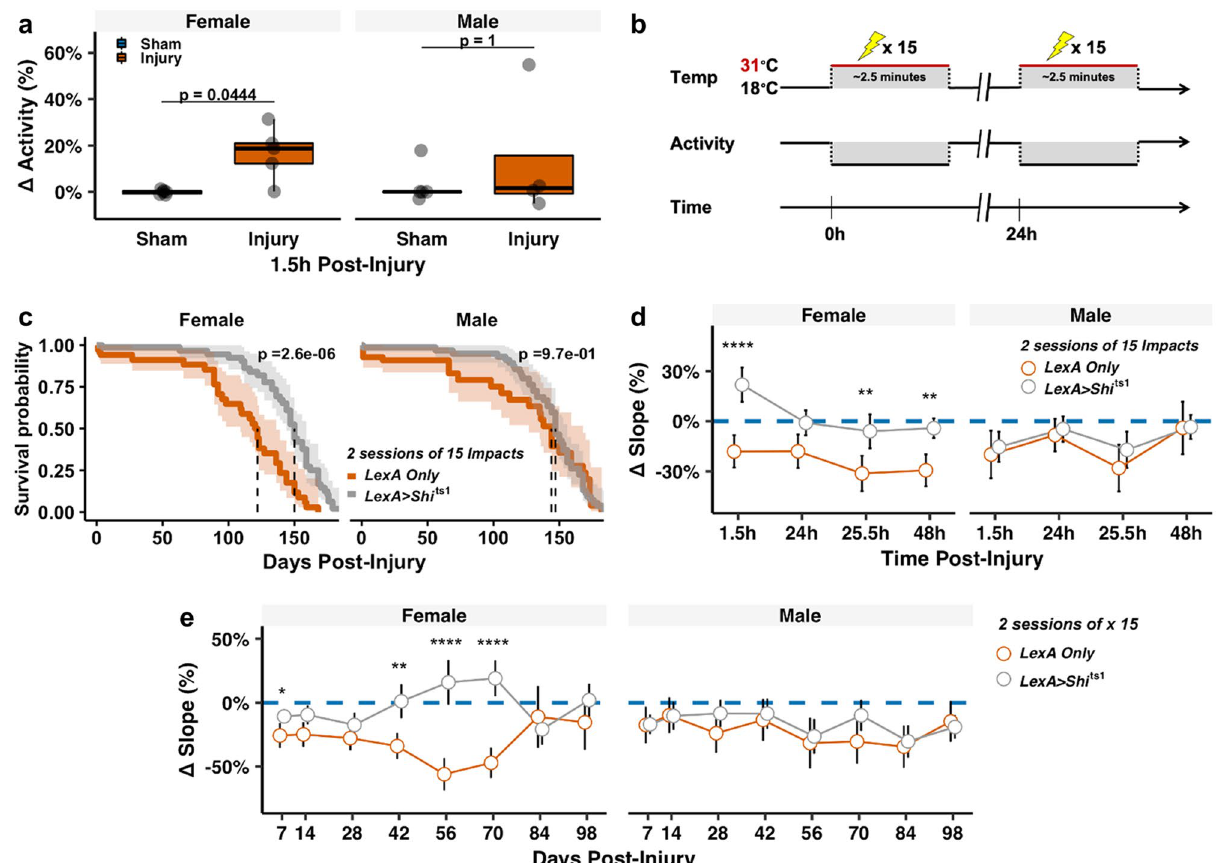
Figure 5. Long-term benefit of suppressing acute injury-induced neuronal activity following repetitive head impacts preferentially affects females. ( a) Quantification of neuronal activity using mushroom body in vivo calcium monitoring ( OK107 > CaLexA-LUC ) revealed an acute increase in neuronal activity 1.5 h following repetitive head impact exposure in lysates collected from injured female brains, but not males. Within sex differences between injury and sham were analyzed using the Mann–Whitney U test with Bonferroni correction, n = 4–7 lysates per group (2–4 fly heads per lysate). ∆ activity = ( (Sample luminescence)- (Median Sham Luminescence))/(Median Sham Luminescence). Boxplots contain individually plotted values with whiskers corresponding to the maximum 1.5 interquartile range. ( b) Schematic overview of strategy to conditionally silence neuronal activity using the pan-neuronally expressed temperature-sensitive hypomorphic null allele, Shibire ts1 during the repetitive injury induction period. 18 °C → 31 °C shift conditionally suppresses neuronal activity for 2.5 min during delivery of repetitive head impacts in pan-neuronally shi ts1 -expressing flies ( LexA > shi ts1 ). (c) Kaplan–Meier survival curves showing that blocking neuronal activity at the time of injury protects against shortened lifespan following injury exposure which preferentially benefits female flies. p -values were calculated using the Mantel-Cox log rank test with Bonferroni correction and correspond to within sex differences between injured LexA only and Shibire ts1 -containing flies ( LexA > shi ts1 ). (d,e) Blocking activity protects against ( d) acute and ( e) chronic climbing deficits related to repetitive head impact exposure that are preferentially found in females. Plotted values in ( d,e) are relative median slopes (relative to respective uninjured sham) with 95% confidence interval error bars. Differences in climbing behavior were analyzed using the Mann–Whitney U test with Holm correction, between injured LexA Only and Shi ts1 -containing flies ( LexA > shi ts1 ). *p < 0.05, **p < 0.01, ***p < 0.001, ****p < neurodegeneration 36,69–73 , including those involved in axonal transection-mediated degeneration, that have been validated by subsequent murine 74–76 and human studies 77 . Existing head trauma models have also demon- strated conserved neuropathology in flies that recapitulates human aspects of head trauma 8 , including frank neurodegeneration 48 , and other cellular pathologies implicated in chronic traumatic encephalopathy, such as hyperphosphorylation of tau 45 and abnormal accumulation of TDP-43 78 . The findings from our study not only support the use of Drosophila as a model system to study the long-term brain degeneration and dysfunction secondary to environmental insults, but also provide crucial insight into the underlying mechanisms involv- ing excitatory neuronal activity in the development of brain deficits induced by head trauma. Our finding that silencing neuronal activity largely abolishes the long-term detrimental effects on fly behavior and brain pathol- ogy is consistent with the emerging view on the involvement of excitotoxicity in a number of neurodegenerative